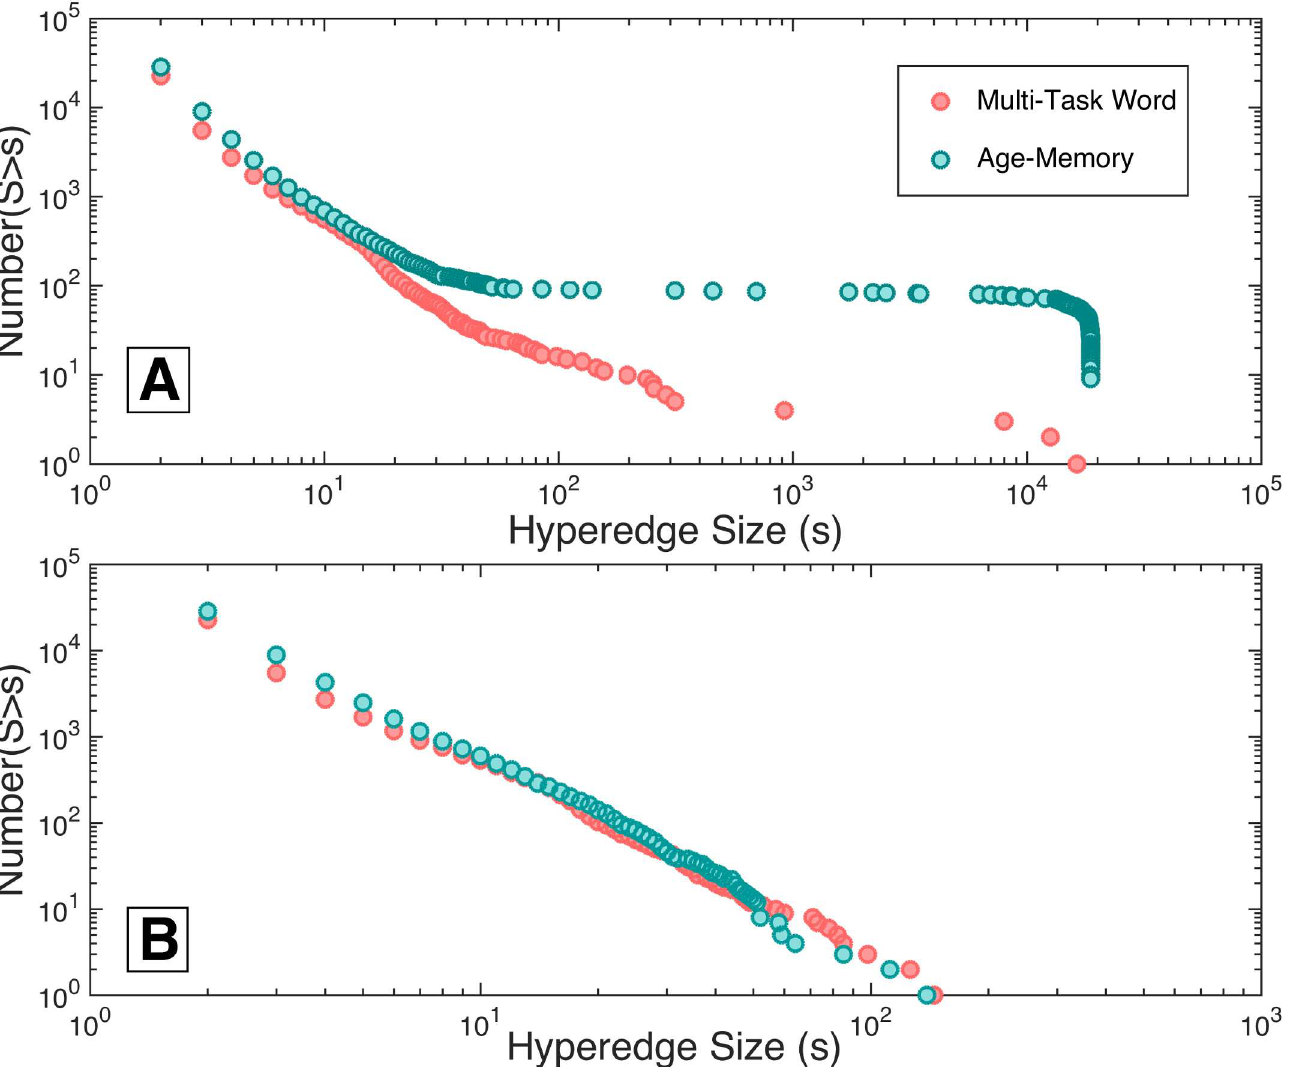
Fig 7. Comparison of cumulative size distribution. Panel (A) depicts the cumulative distributionof hyperedge sizes over all individualsin the age- memory study compared with the sizes of the set of hyperedgesconstructed from only the word-memory task of the multi-task data set. Differencesin the number of large hyperedges can be observed between the two tasks, but both contain a similar number of hyperedgesover all individuals. Panel (B) illustrates the cumulative distribution of sizes for all individualsin both studies with the largest hyperedge for each individualsubject removed. When this is done, the distributions overlap and are well describedby a power law with close alignmentin slope and magnitudeacross